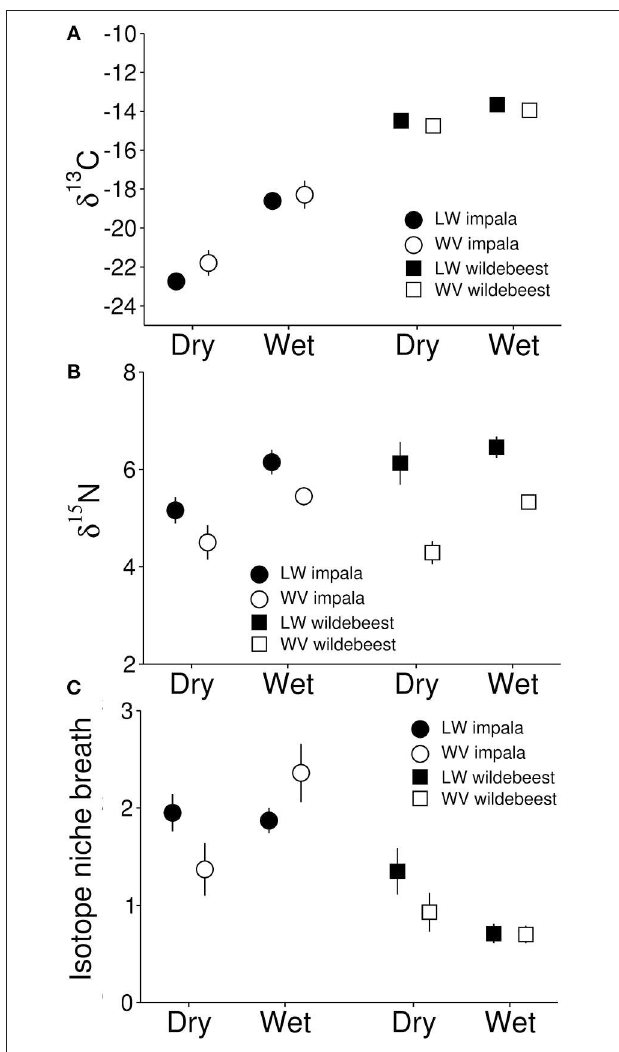
FIGURE 5 | Values of δ 13 C (A) , δ 15 N (B) , and isotope niche breadth (C) from fecal samples of impala and wildebeest in the two reserves during dry and wet seasons. Isotope niche breath was quantified as the Euclidean distance of each sample to group centroids in a two-dimensional isotope space created by δ 13 C and δ 15 N values. Figures present the mean of 46 groups of impala (containing a total of 59 individuals) and 25 groups of wildebeest (containing a total of 29 individuals) collected in Lapalala, and 17 groups of impala (containing a total of 26 individuals) and 23 groups of wildebeest (containing a total of 27 individuals) collected in Welgevonden. The figure represents means of group means ± 1